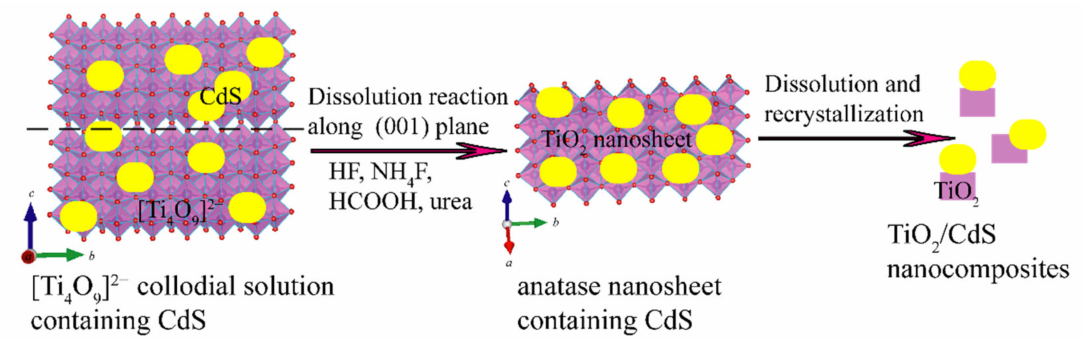
Figure 1. Possible growth mechanism of TiO 2 /CdS